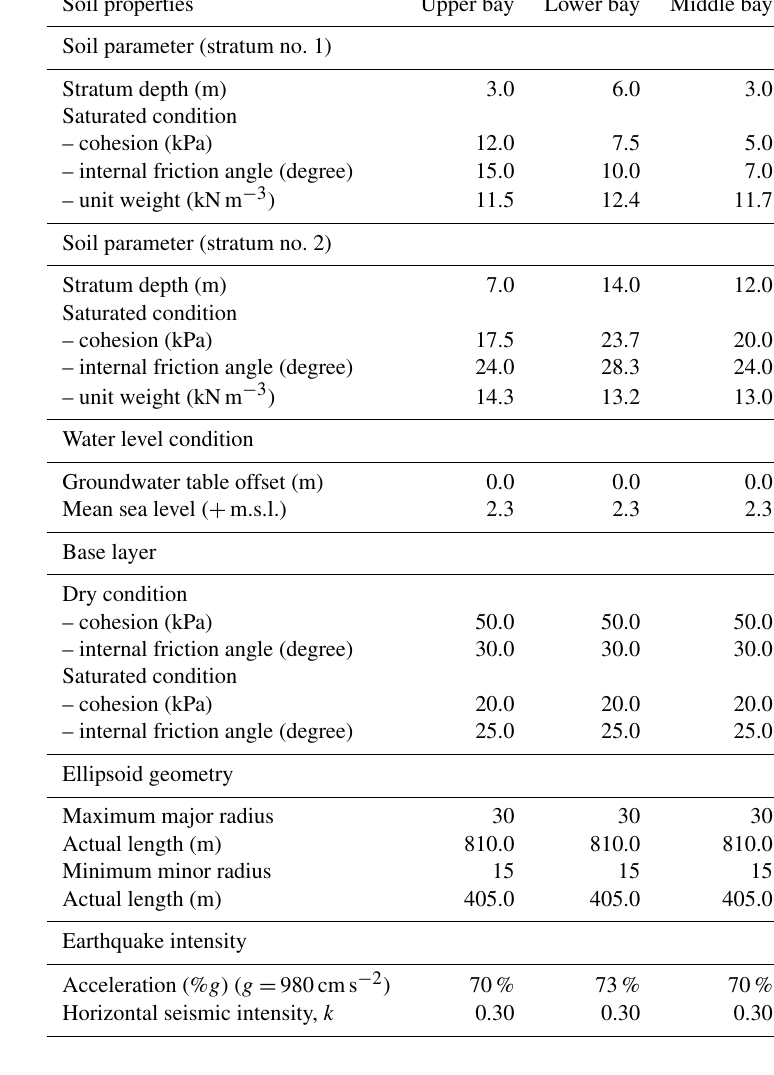
Table 2. Parameter settings for the landslide